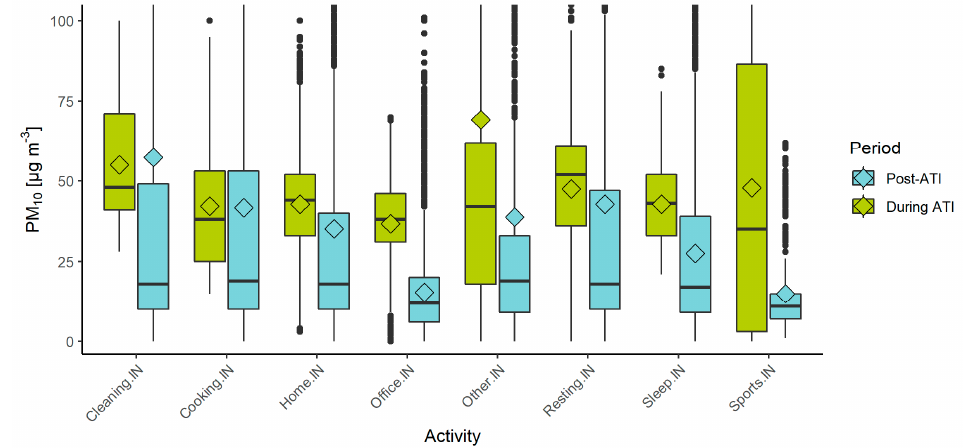
Figure 6. Exposure to PM 10 for different indoor activities, during the ATI event (green) and after (blue), collected with the PPMs. Plot limited to 100 µg/m 3 on the y axis to better illustrate the differences.